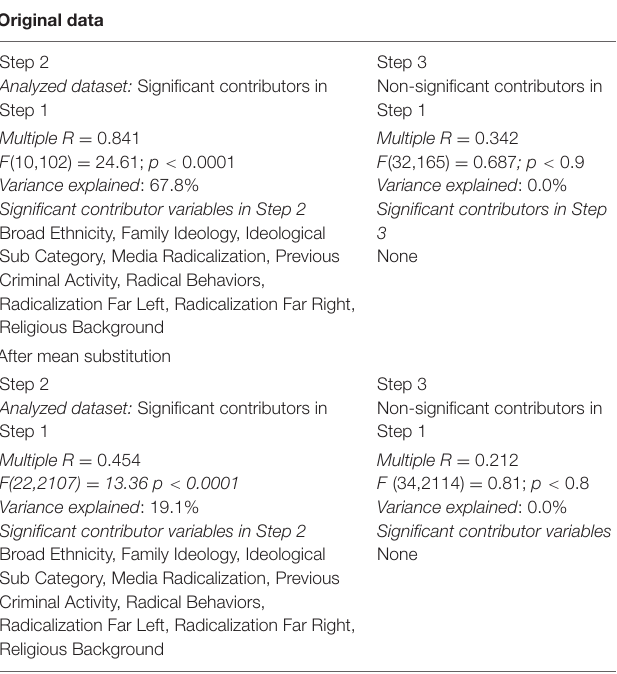
TABLE 3 | Multiple Regression analysis of variables having or not having significant contributions to prediction in Step 1. Original